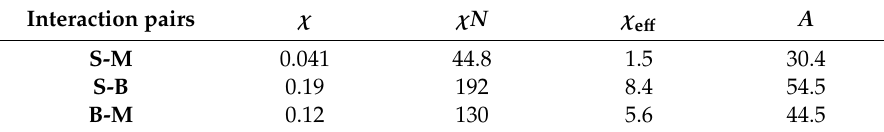
Table 2. Interaction parameters for the S-M, S-B, and B-M particle